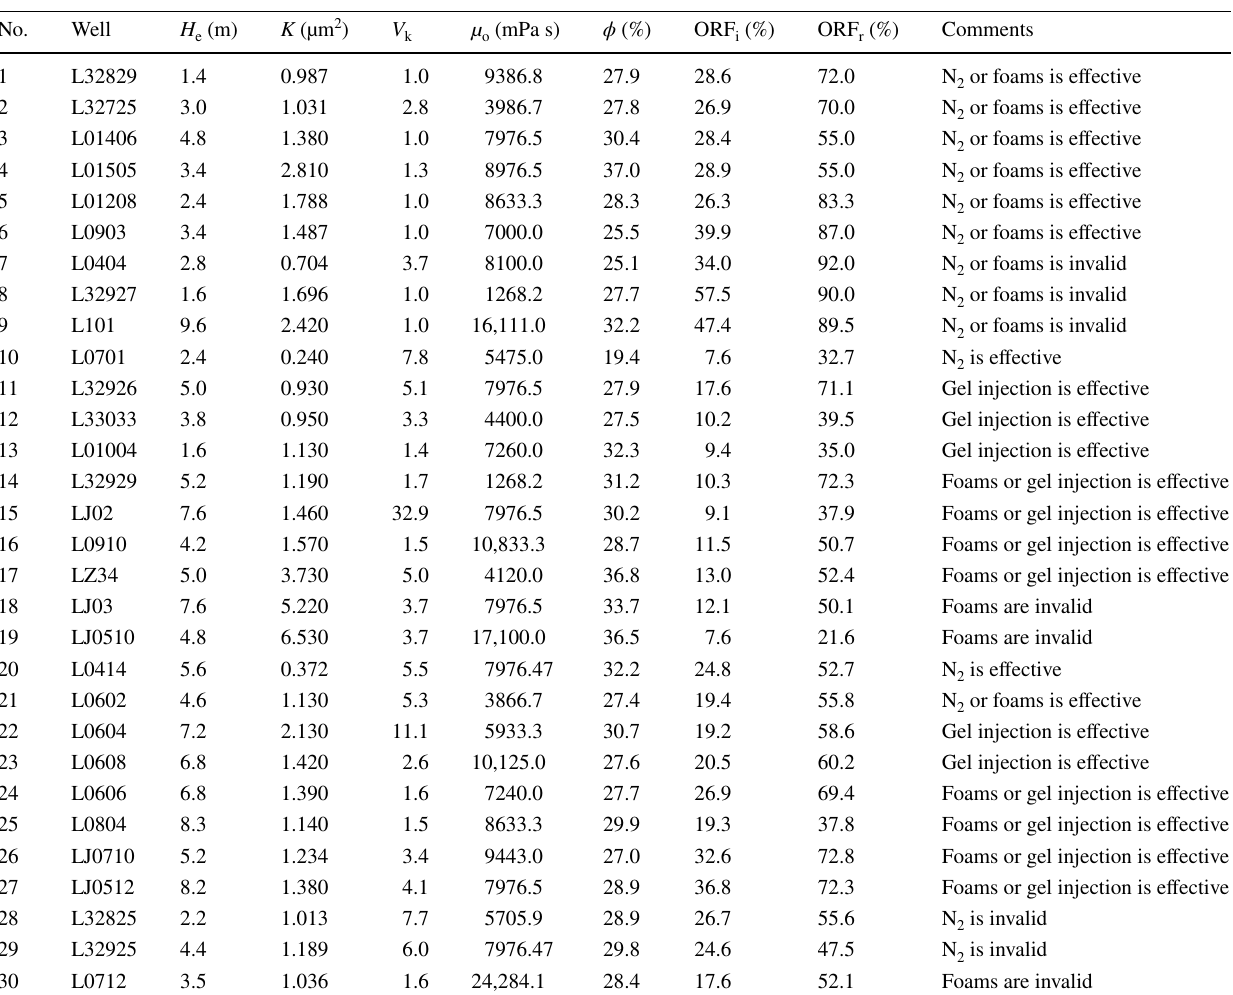
ORF i is the oil recovery factor of original oil reserves, ORF r is the oil recovery factor of single-well recoverable